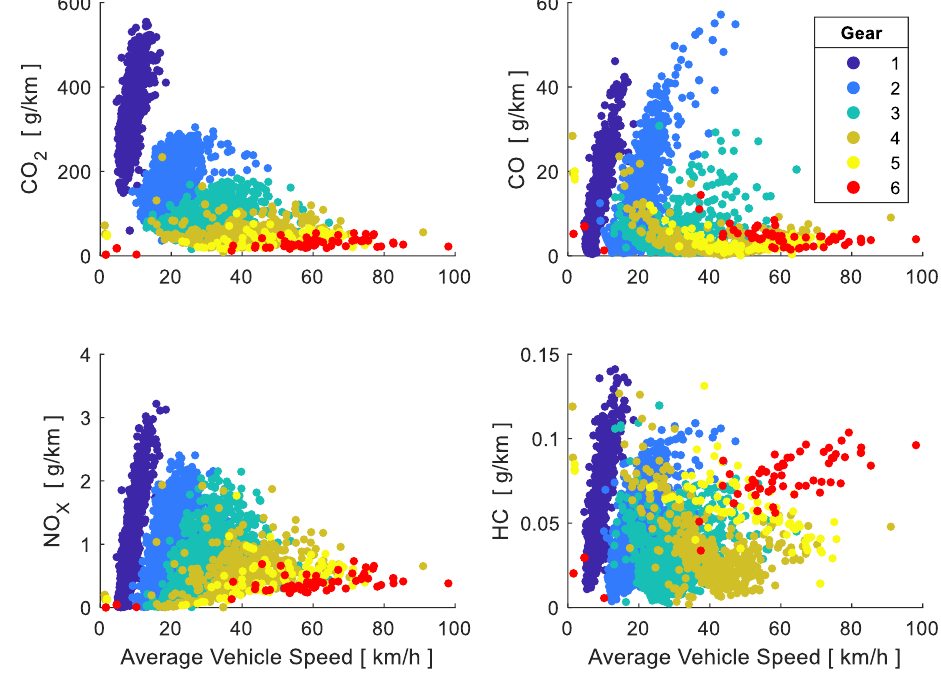
Figure 10. Emission factors according to average speed and gear used.